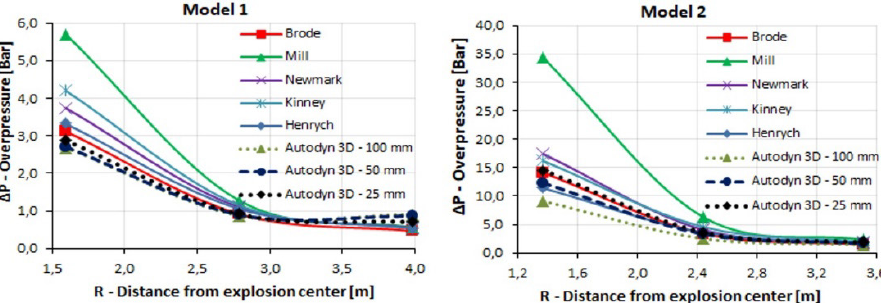
Figure 10. Overpressure peaks on gauges 1, 2, and 3 for models 1 and 2.